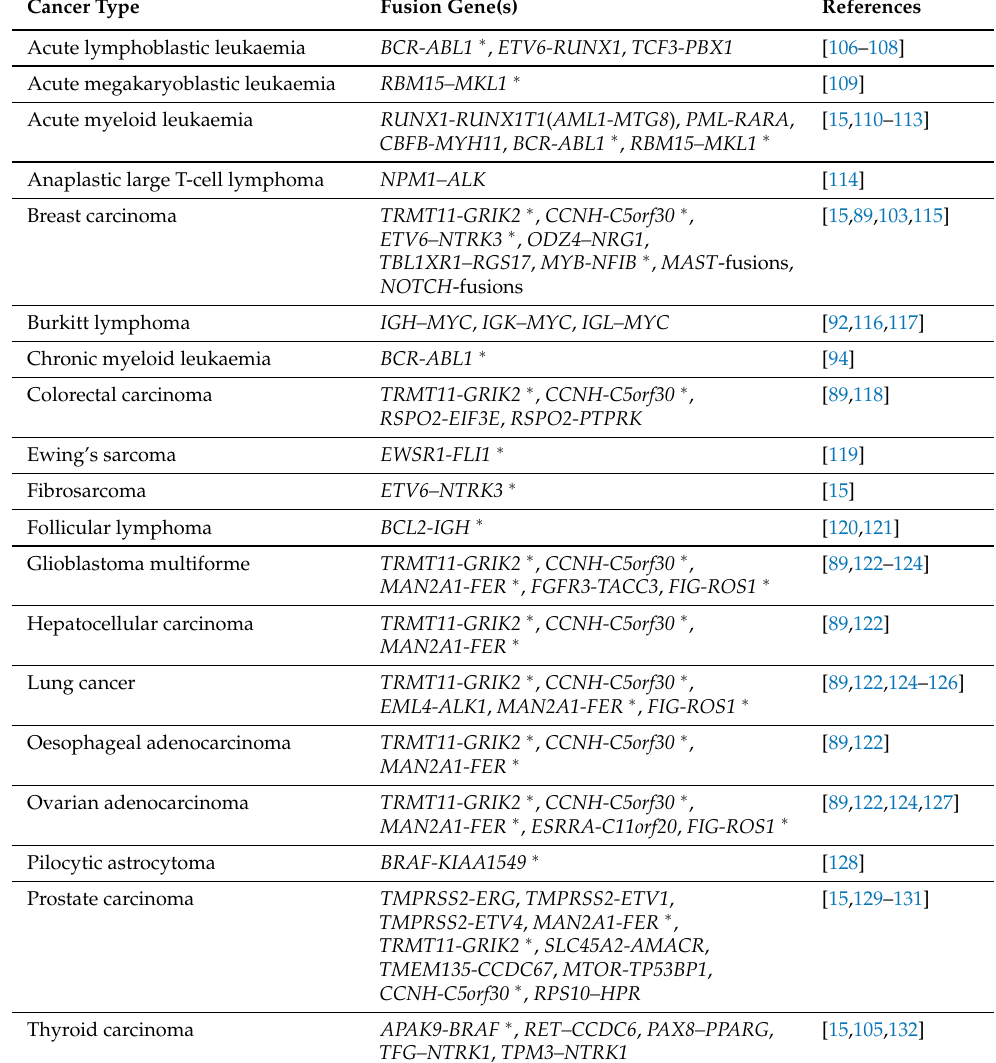
Table 1. List of common fusion genes identified in